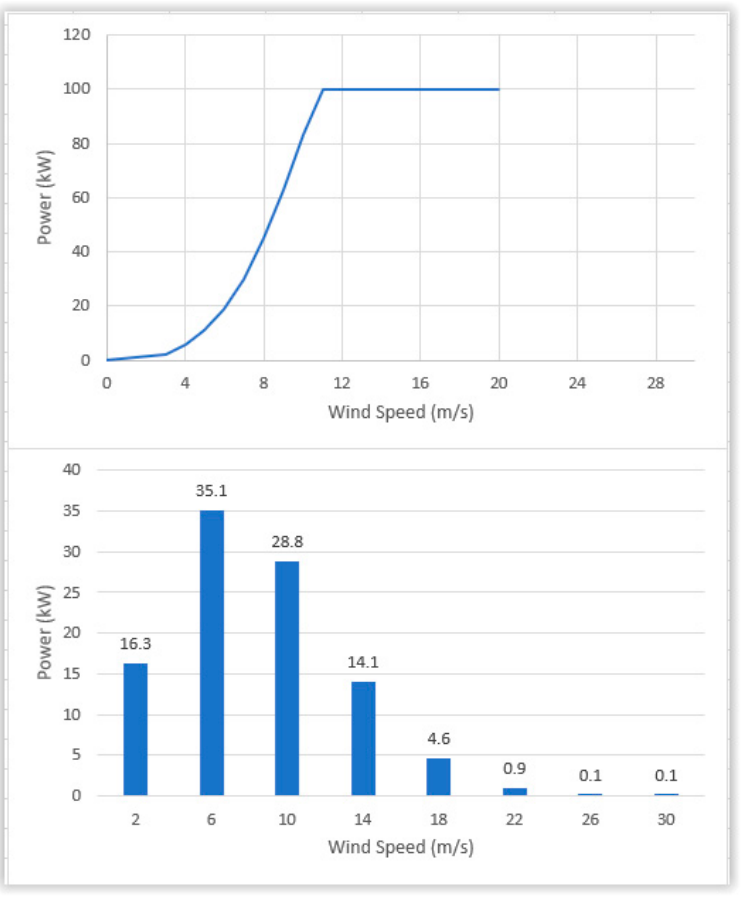
Figure 8. The power curve ( top ) and power generation distribution ( bottom ) of the XANT M-21 turbine.